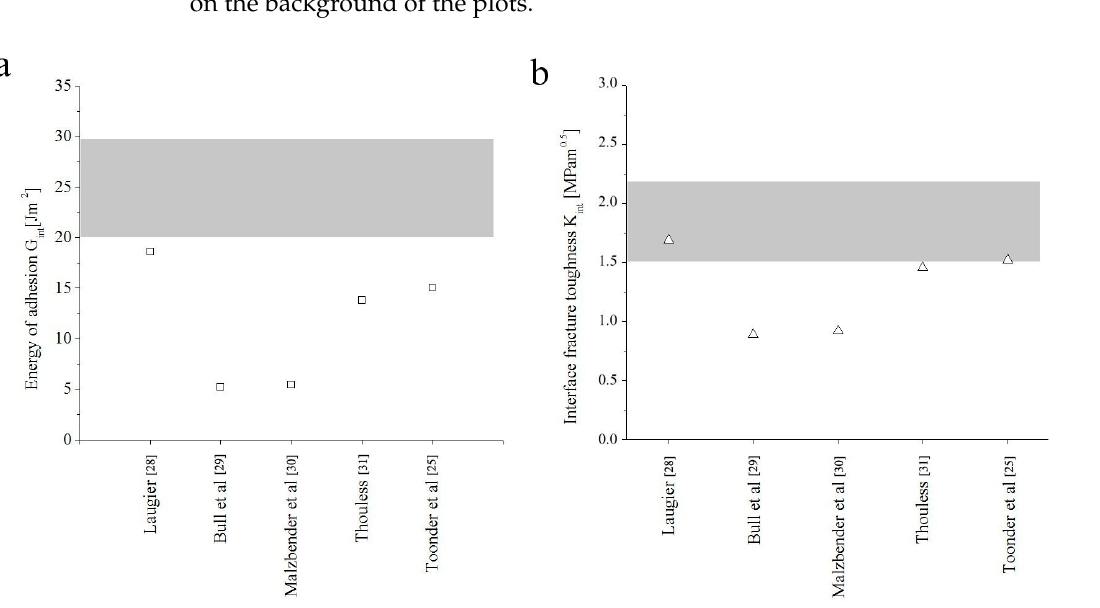
Figure 10. ( a ) Adhesion energy and ( b ) interface fracture toughness as calculated from the imple- mented models. The gray shaded band indicates the domain of the properties previously calculated through nanoindentation [16].